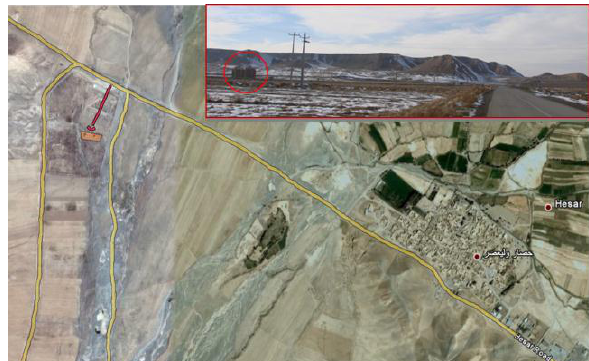
Figure 1. The location of Kharraqan Tomb Towers near Hisar-e Valiasr in Qazvin, as it is obvious they are located in a flat plain These two towers are particularly notable for their vivid external decoration, which classes them amongst the finest decorated brick monuments found in Iran (Briseghella & Kalhor,